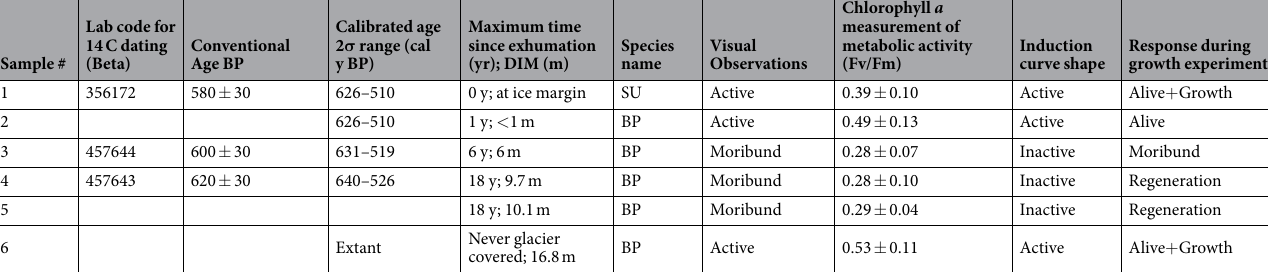
Table 1. Moss samples collected along the boundary of the Wormald Ice Piedmont from the ice/glacier foreland, presenting conventional and calibrated age 2 σ range (cal y BP); maximum time since exhumation after glacier retreat (see Fig. 1B); minimum distance from the ice margin (m) (DIM); species name; visual observations (field and dissecting microscope prior the 2014 regrowth experiment); value of Fv/Fm (variable fluorescence/maximum fluorescence) of the chlorophyll a fluorescence measurements; shape of the induction curve obtained during chlorophyll a fluorescence measurements; response during the growth experiment. Legend: BP = Bryum pseudotriquetrum ; SU = Sanionia uncinata